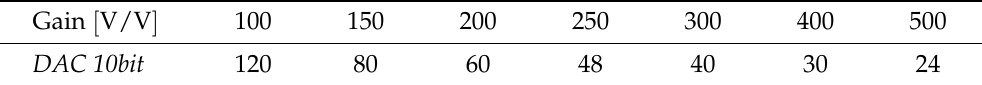
Table 2. Specified gain and DAC 10bit pairs used during channel gain characteristics measurement.